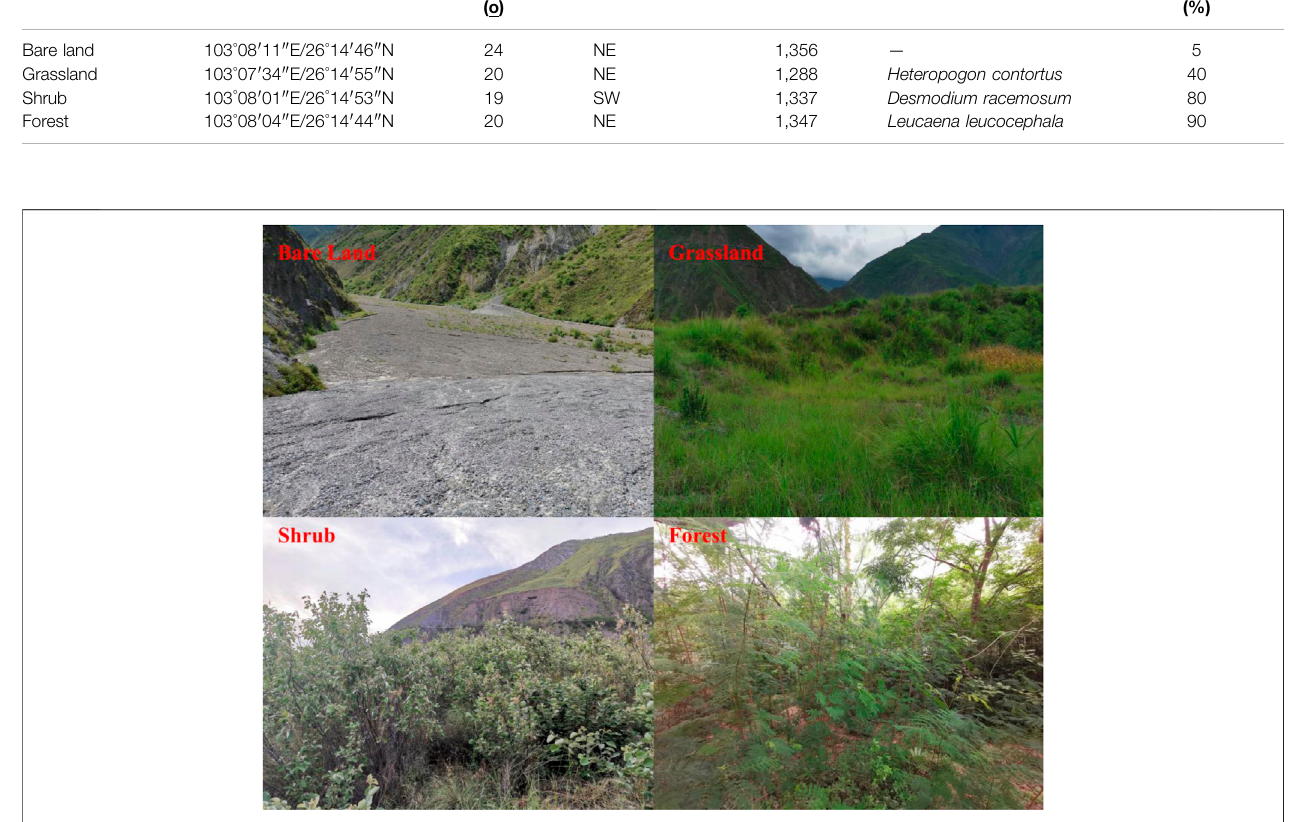
FIGURE 2 | Field views of four vegetation